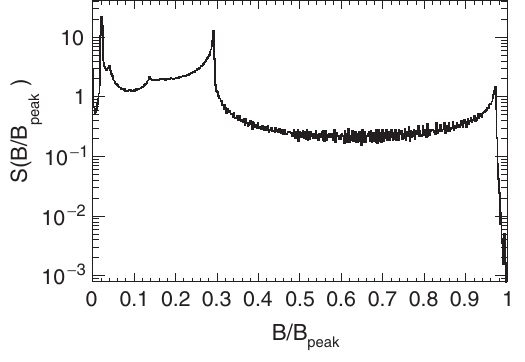
FIG. 11. Quality factor as a function of accelerating gradient in the welded series production cavities.